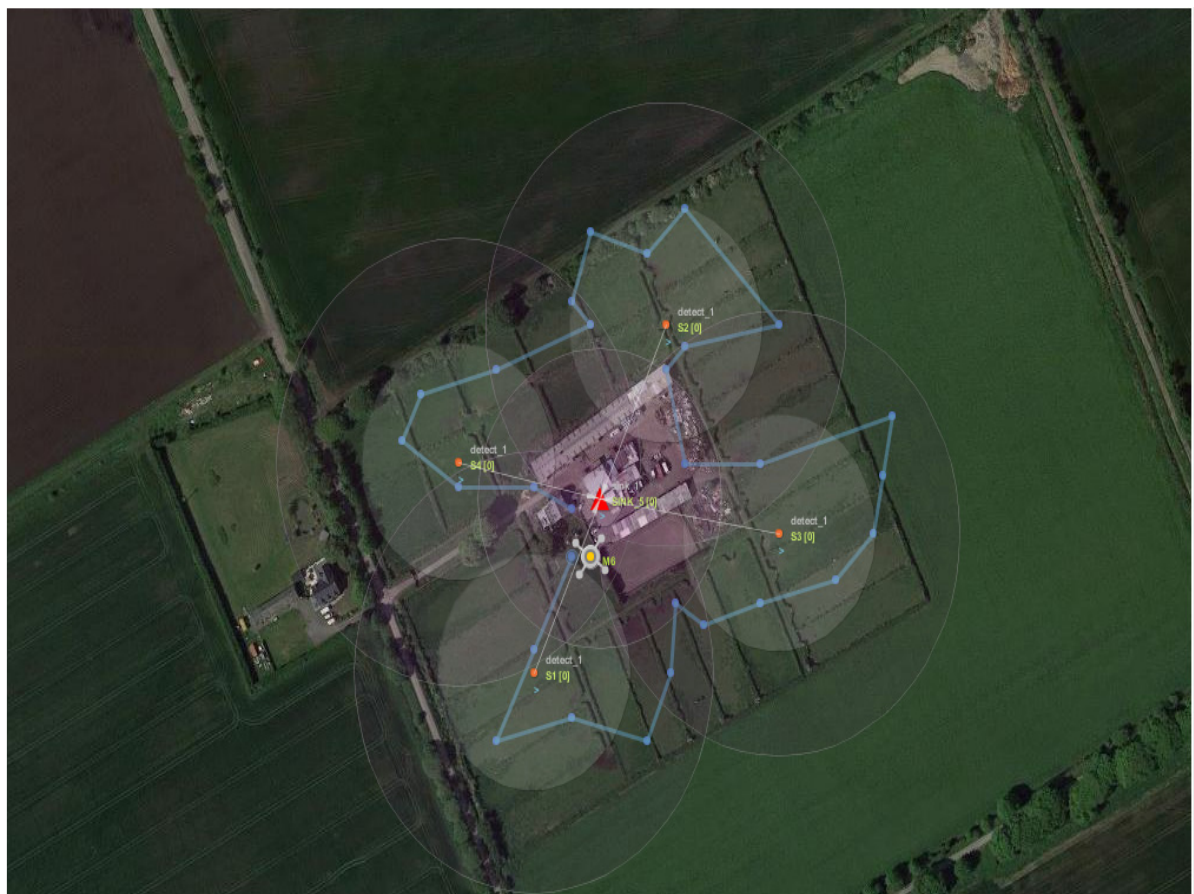
Figure 8. Cup Carbon Simulation field, which consists of Clusters.